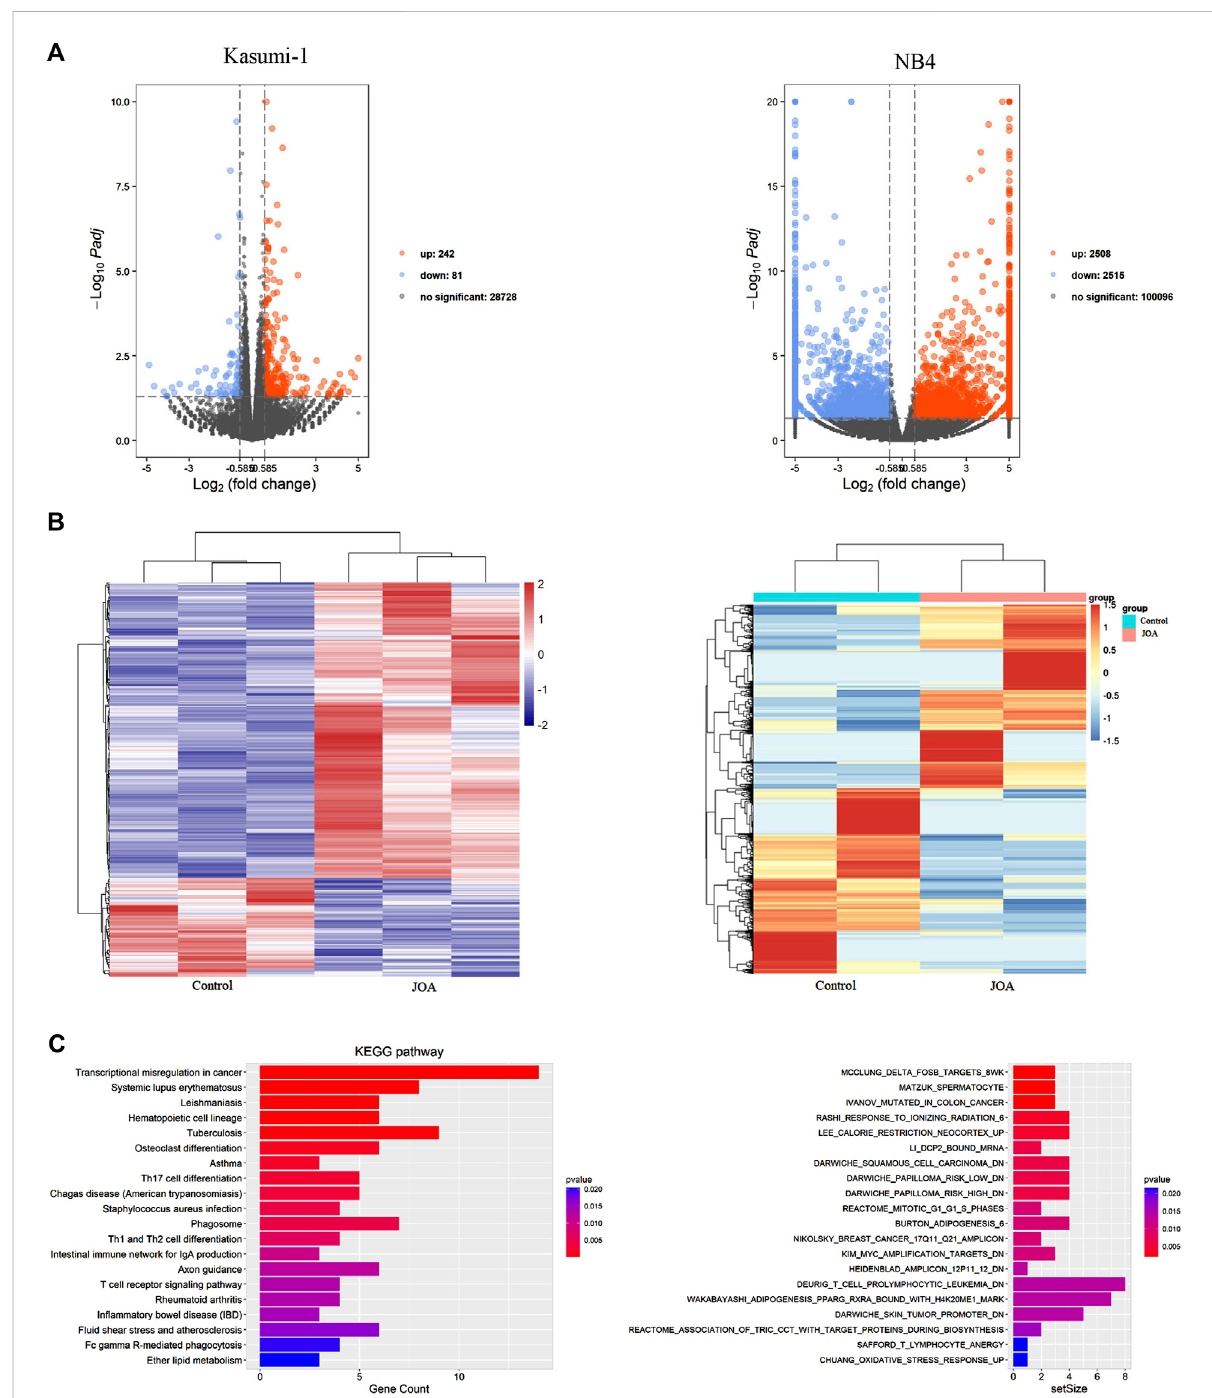
mRNA sequencing analysis in Kasumi-1 and NB4 cells treated with JOA. (A) Volcano plots of Kasumi-1 and NB4 cells. (B) Heatmap of all DEGs. The bars from blue or violet to red denote the expression levels of DEGs from low to high. (C) KEGG or GSEA analyses on all DEGs. Kasumi-1 and NB4 cells were incubated with 1 µM of JOA for 48